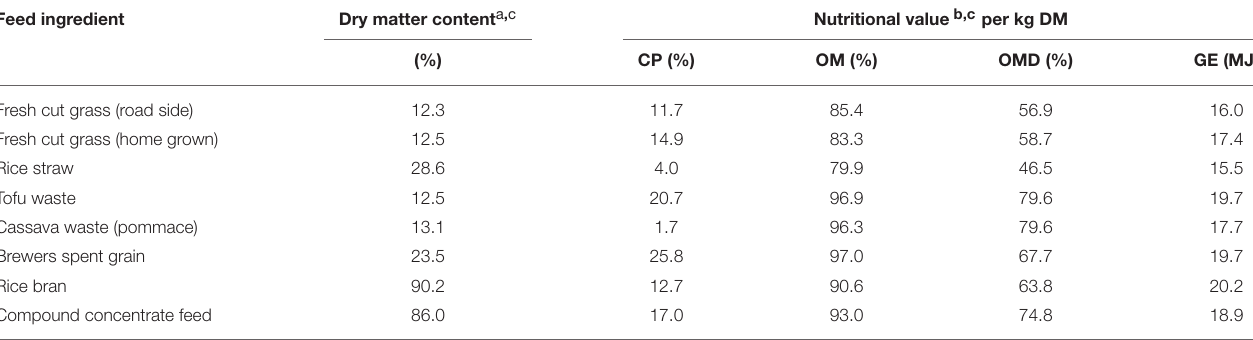
TABLE 2B | Nutritional values of feed ingredients. Feed